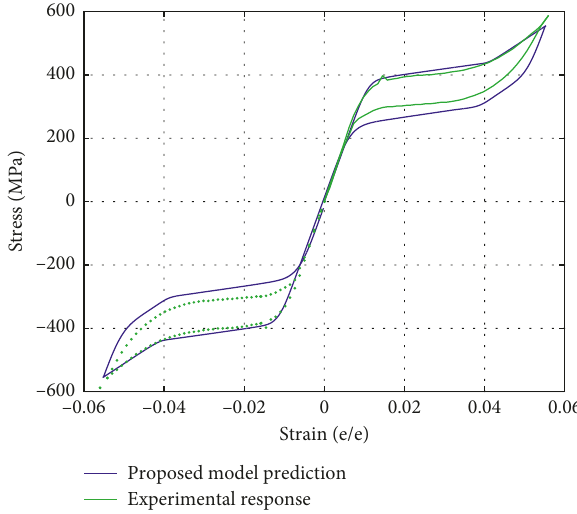
Figure 8: Comparison of the proposed model prediction to ex- perimental response at a frequency of 1Hz.